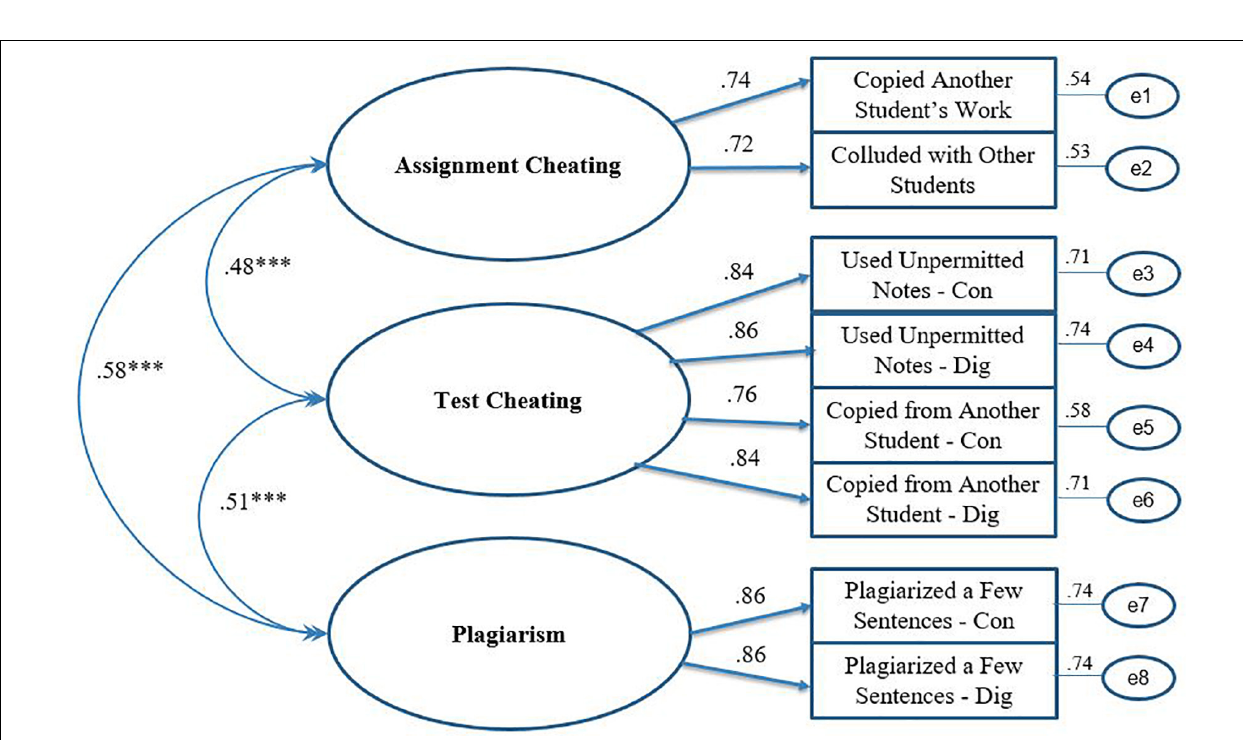
FIGURE 3 | Standardized estimates of the three-factor measurement model of academic dishonesty. Model 1.1 – Full Sample. ∗∗∗ p <